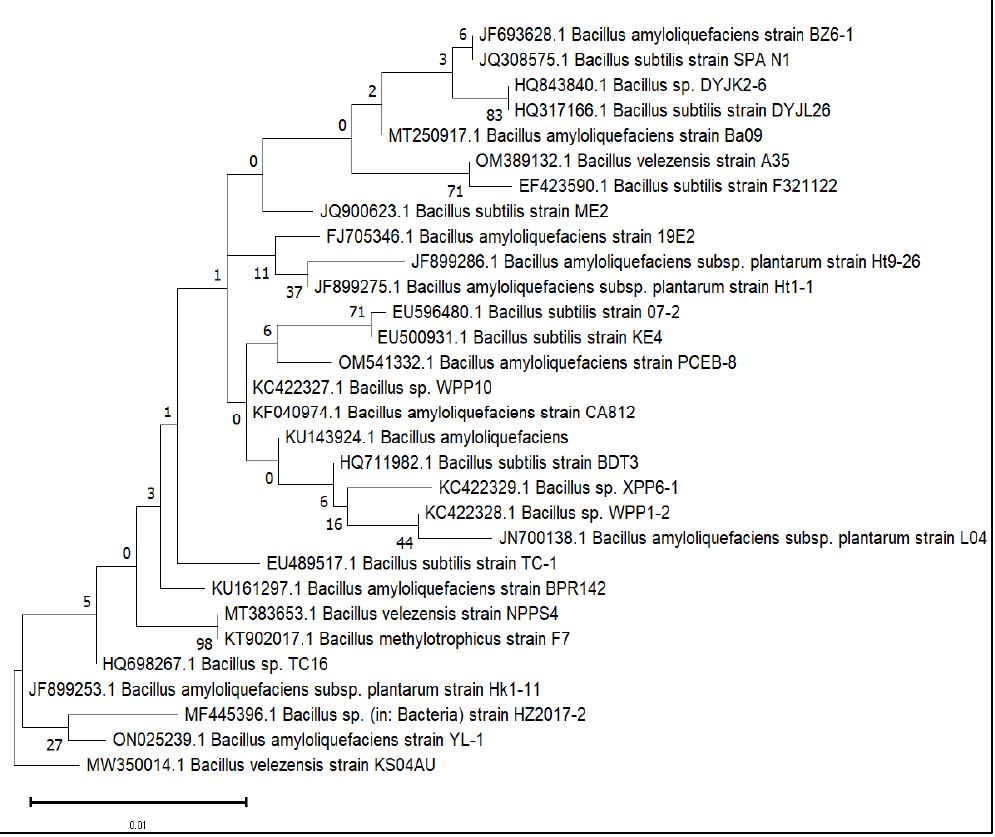
Figure 2. The phylogenetic analysis based on the 16S rRNA genes of strain KS04AU based on NCBI blast System. The tree was generated by MEGA 11 using the neighbor-joining